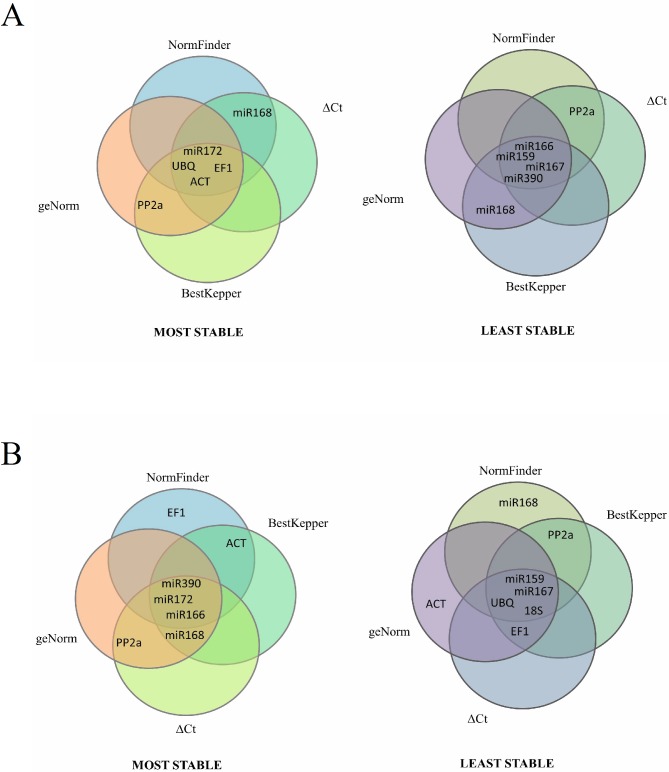
Venn diagram indicating the most and least stable RGs identified by geNorm, NormFinder, BestKeeper and ΔCt.A- Leaves and flowers (set 7). B- Virus infection (set 11).